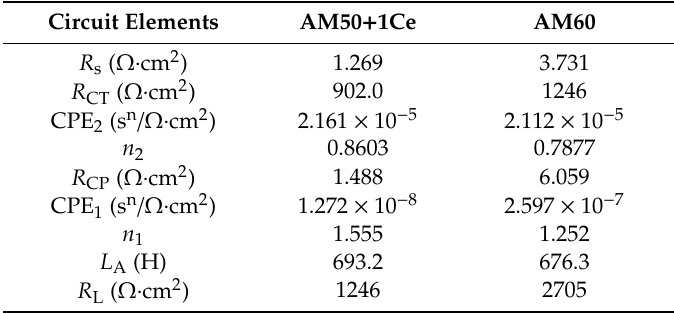
Figure 13. Equivalent electrical circuit used to fit the EIS spectra of HPDC AM50 + 1Ce and AM60 magnesium alloys. Table 3. Fitting results from polarization curves of HPDC AM50 + 1Ce and AM60 magnesium alloys